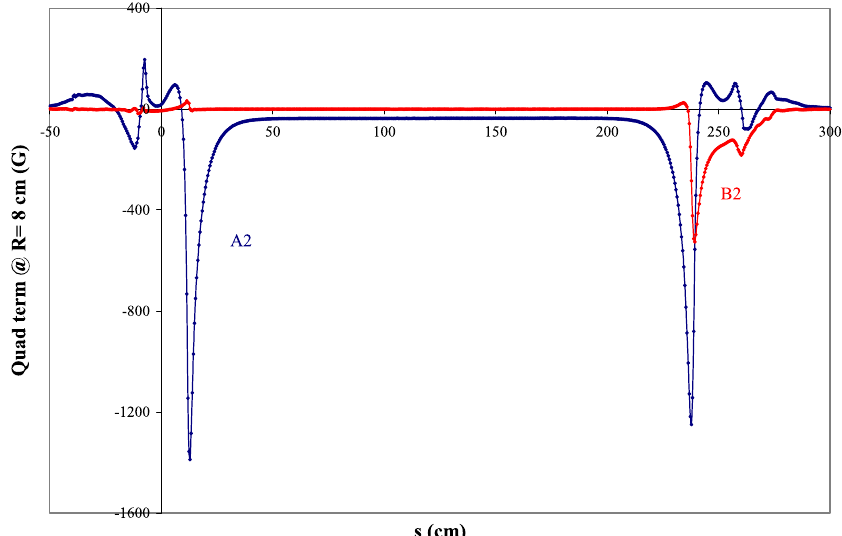
FIG. 9. (Color) Quad term of the field on a cylindrical surface surrounding a reference